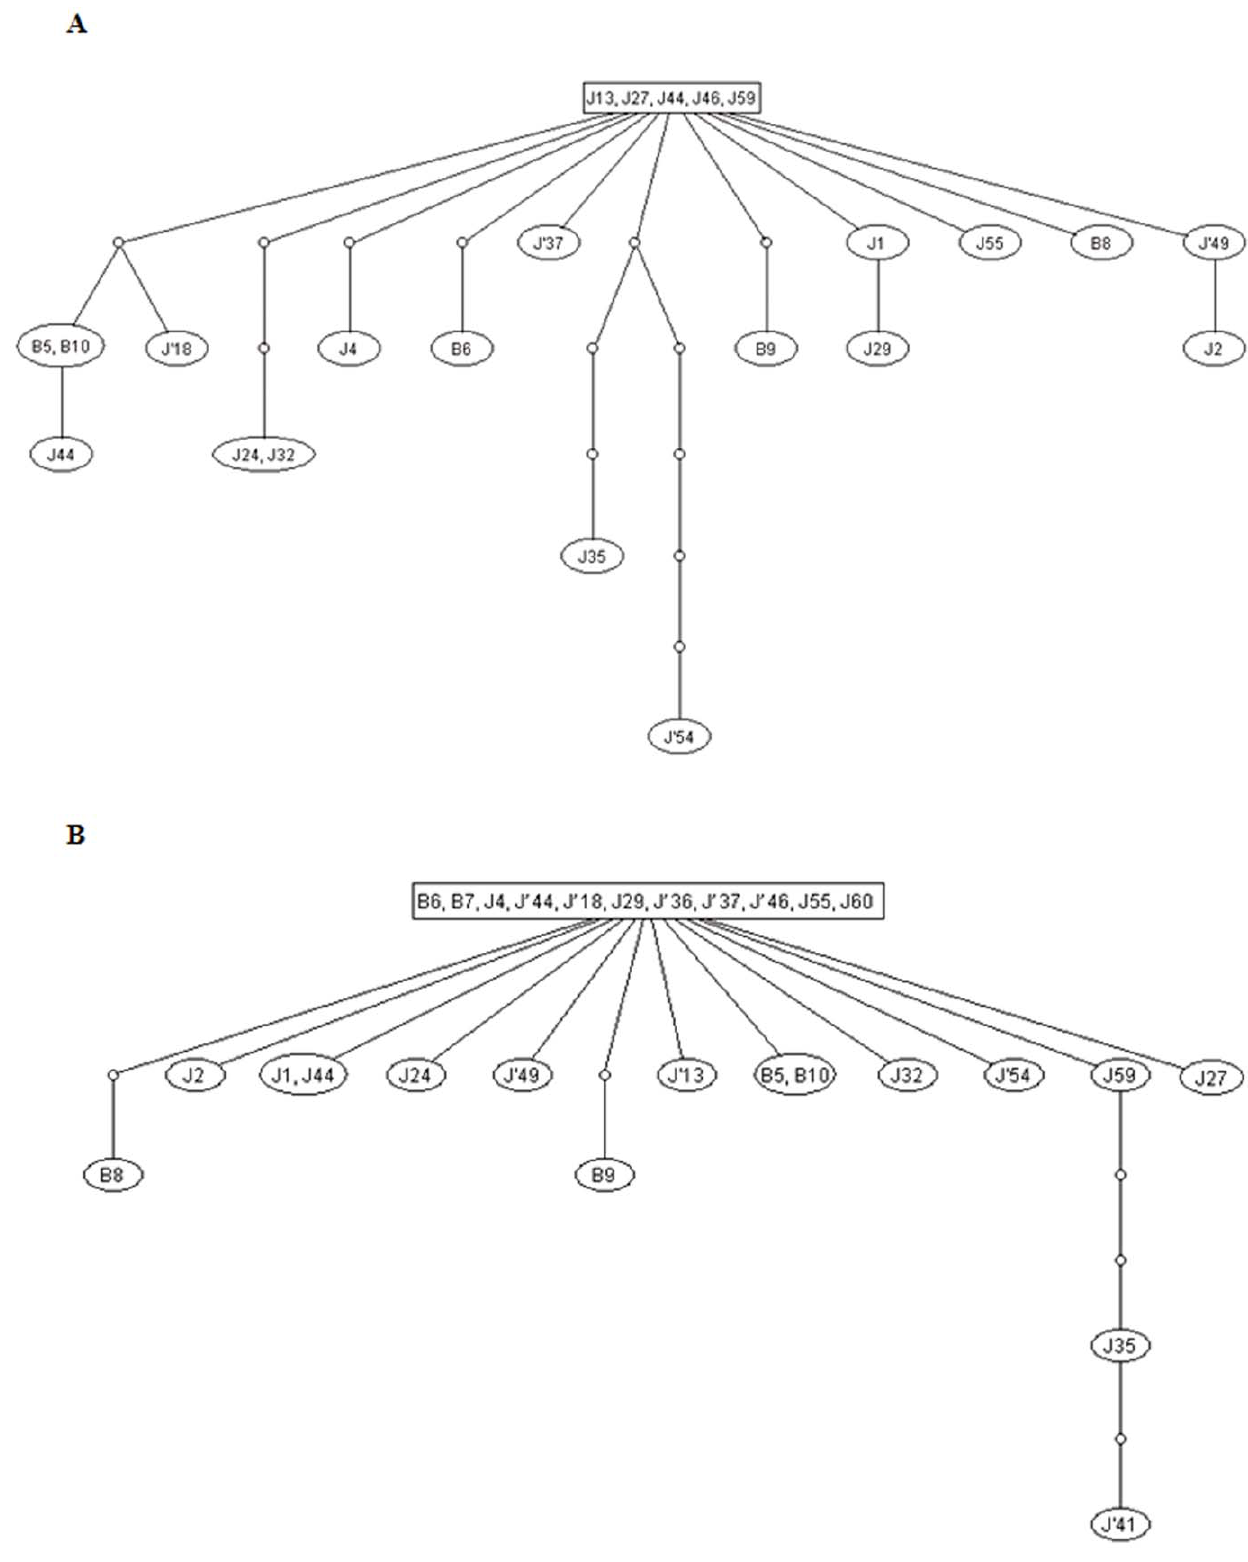
Figure 5. Genealogy of the LNV segments 12 and 10 of the isolates from the Xinjiang province. Parsimony analysis by TCS of segments 10 (A) and 12 (B) of the LNV isolates from the Xinjiang province. Connecting lines represent a nucleotide substitution. Sequenced haplotypes (oval circles), and putative ancestral virus haplotypes (small circles) are shown. In segment 10, the network show a group of 5 isolates from Jiashi, that is directly linked to other isolates from Jiashi and Boshikeranmu. Only isolates J 9 36, J 9 41, J60 and B7 do not figure in this network. In segment 12 a larger group (including 11 isolates) is linked to all remaining isolates. doi:10.1371/journal.pone.0037732.g005 PLoS ONE |